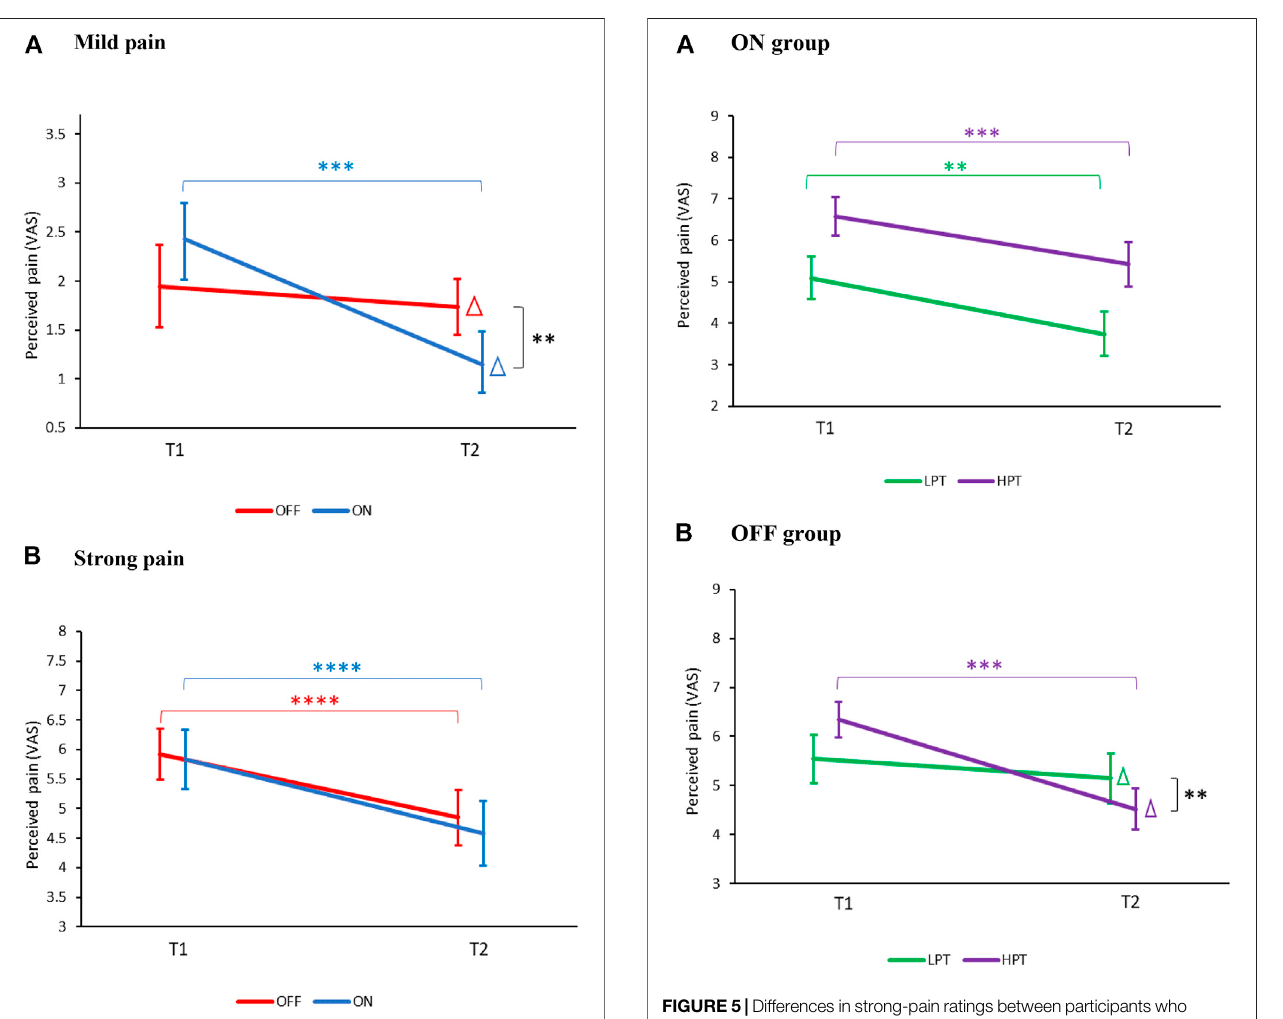
FIGURE 5 | Differences in strong-pain ratings between participants who gavehighvs.lowratingstothepleasantnessoftouchingPARO. (A) Withinthe ONgrouptherewasasigni fi cantdecreaseinpainratingsfromT1toT2bothin HPT (*** p < 0.001, purple) and LPT (** p < 0.01, green). (B) Within the OFF group there was a signi fi cant decrease in pain ratings from T1 to T2 only in HPT (*** p < 0.001). The change in pain ratings from T1 to T2 (marked with a Δ ) was signi fi cantly different between the HPT and LPT sub-groups (** p < 0.01). Values denote mean visual-analogue scale (VAS) ratings (0 – 10) ± SEM. T1 — before encountering PARO, T2 — while touching PARO. HPT — participants who gave above-median ratings to the pleasantness of touching PARO. LPT — participants who gave below-median ratings to the pleasantness of touching